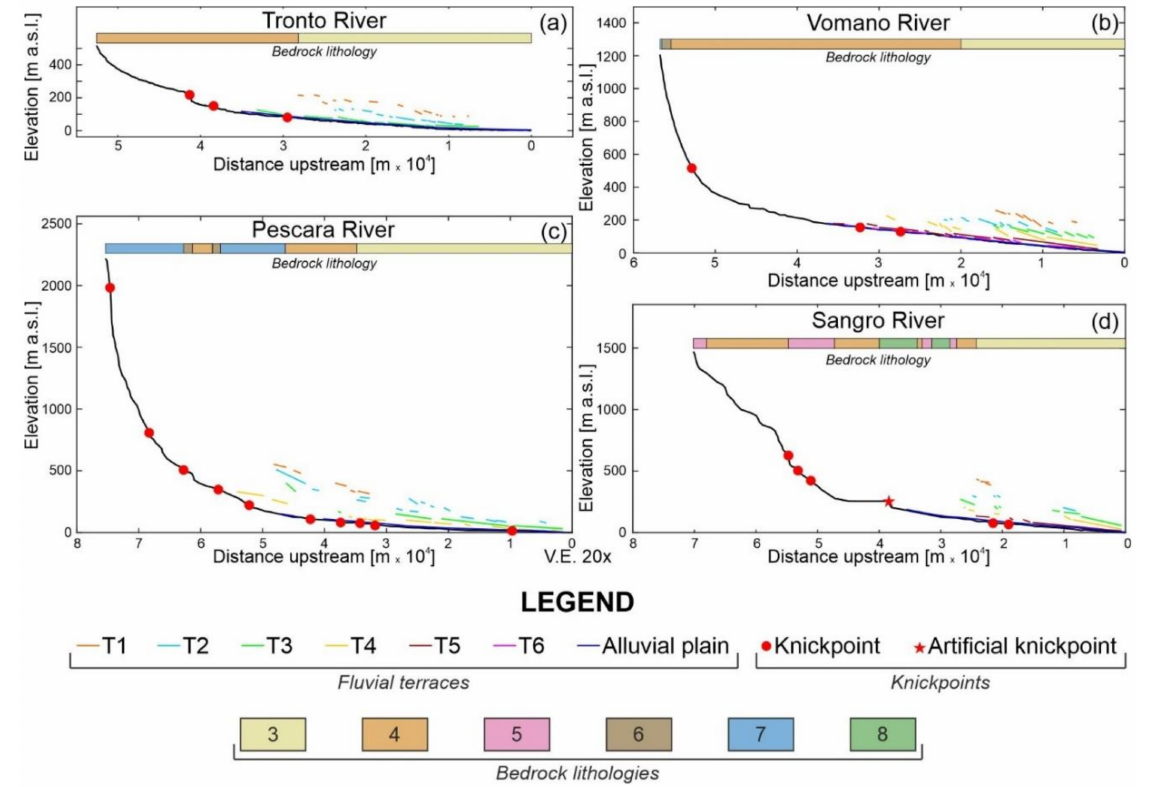
Figure 9. Altimetric and spatial arrangement of terrace remnants along with the longitudinal profiles of analyzed river basins: ( a ) Tronto River; ( b ) Vomano River; ( c ) Pescara River; ( d ) Sangro River. Each longitudinal profile is compared with the along-course lithological configuration (colored bar at the top). For the location of knickpoints see Figure 6. Note: colors and numbers of bedrock lithologies refer to Figure